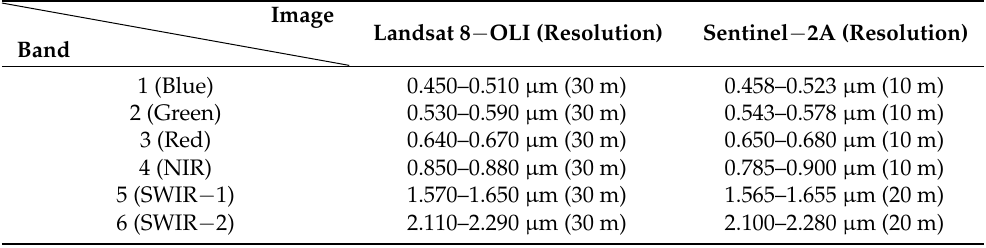
Table 1. The selected bands of image data.